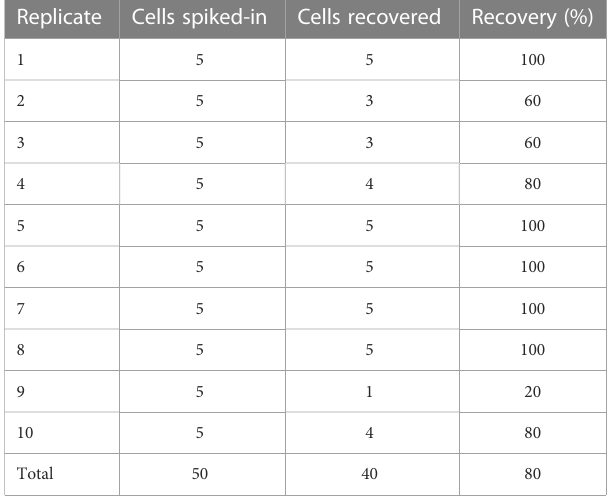
TABLE 1 Recovery of rare cells using 5 spiked-in cells in healthy donor blood. Replicate